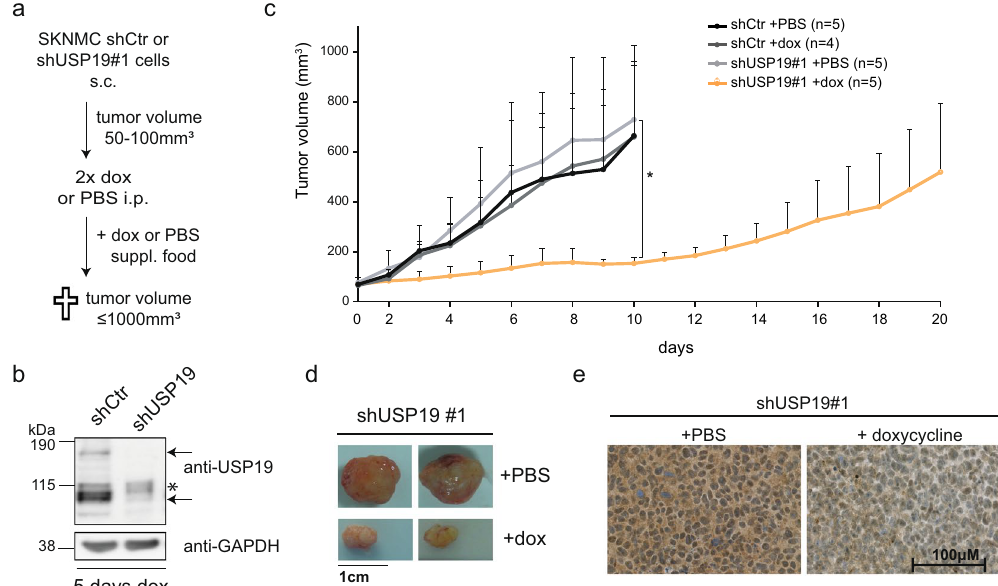
Figure 5. Depletion of USP19 delays tumor growth in vivo . ( a ) Scheme of xenograft experiments using SKNMC inducible cell lines. ( b ) Doxycycline-induced shRNA knockdown against USP19 in vivo . Two mice with engrafted tumors of ~200 mm 3 (shCtr and shUSP19#1) were treated for five days with doxycycline. Tumor lysates were analyzed by western blotting with anti-USP19. ( c ) Tumor growth rate of indicated cell lines and treatment of subcutaneously injected SKNMC cells, error bars as SD. ( d ) Tumors of two representative mice transplanted with SKNMC shUSP19#1 cells and treated with doxycycline or PBS. ( e ) Immunohistochemical analysis of representative sections doxycycline or PBS treated SKNMC shUSP19#1 tumors using an USP19